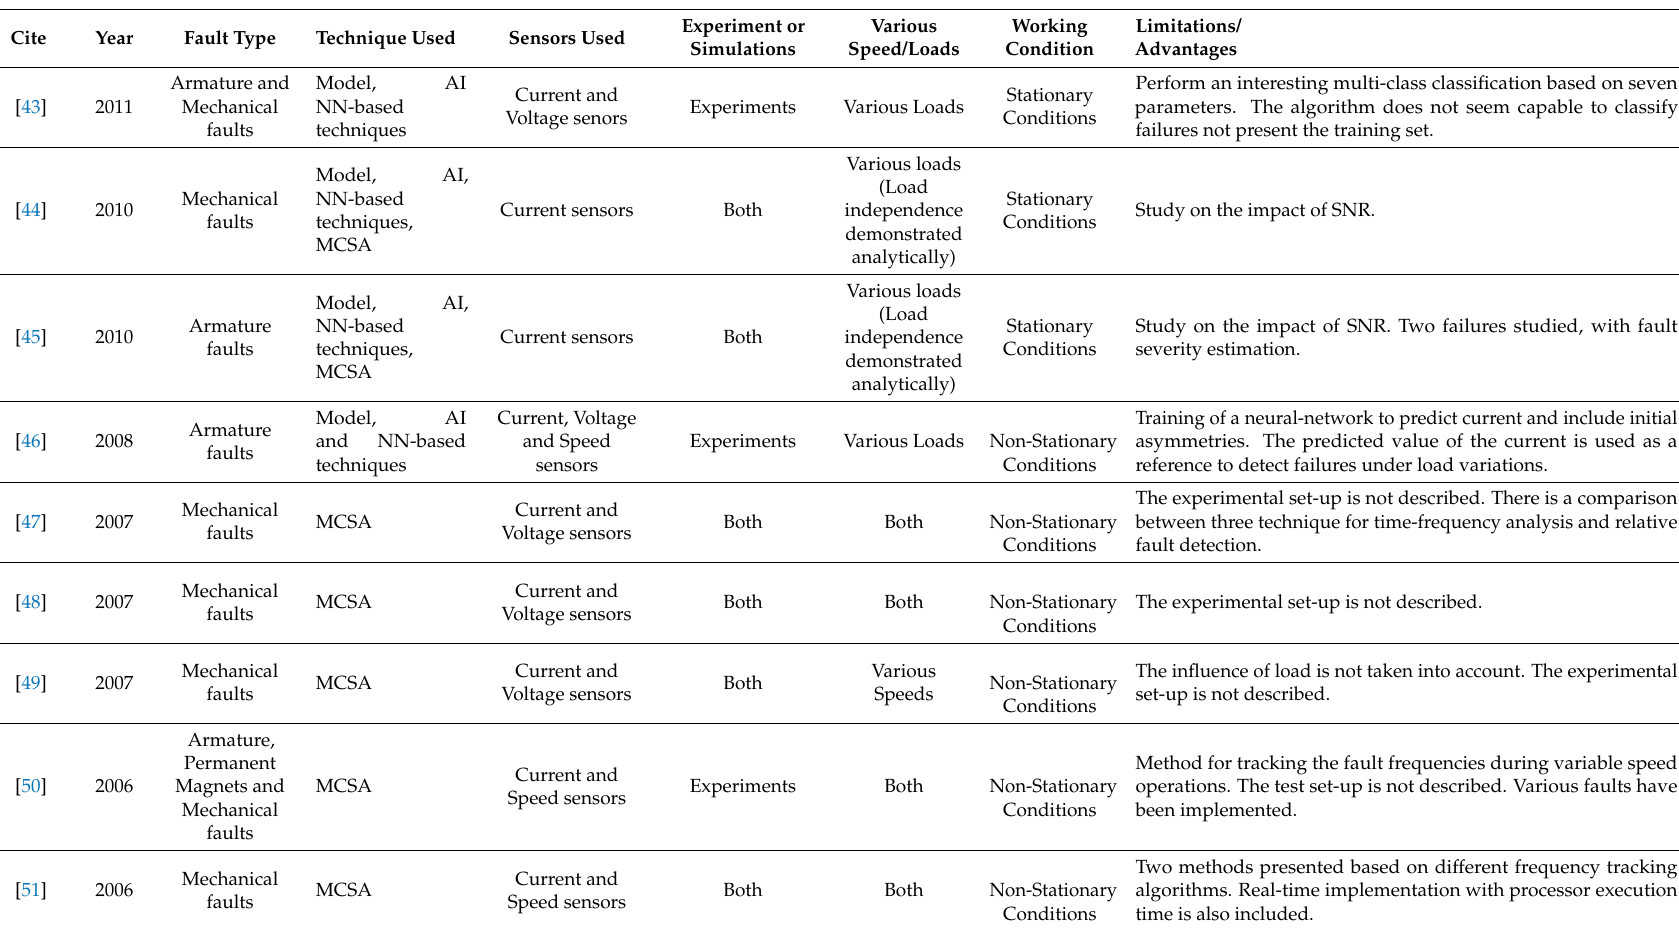
Table 5. Features table